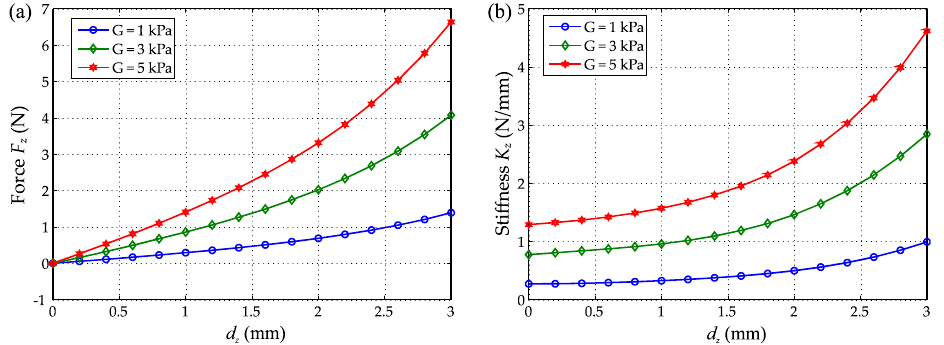
Figure 6. ( a ) The indenting force F z with the indentation depth d z for different materials (Shear modulus G = 1, 3, 5 kPa); ( b ) The compressive stiffness of the elastomer with the indentation depth for different materials.